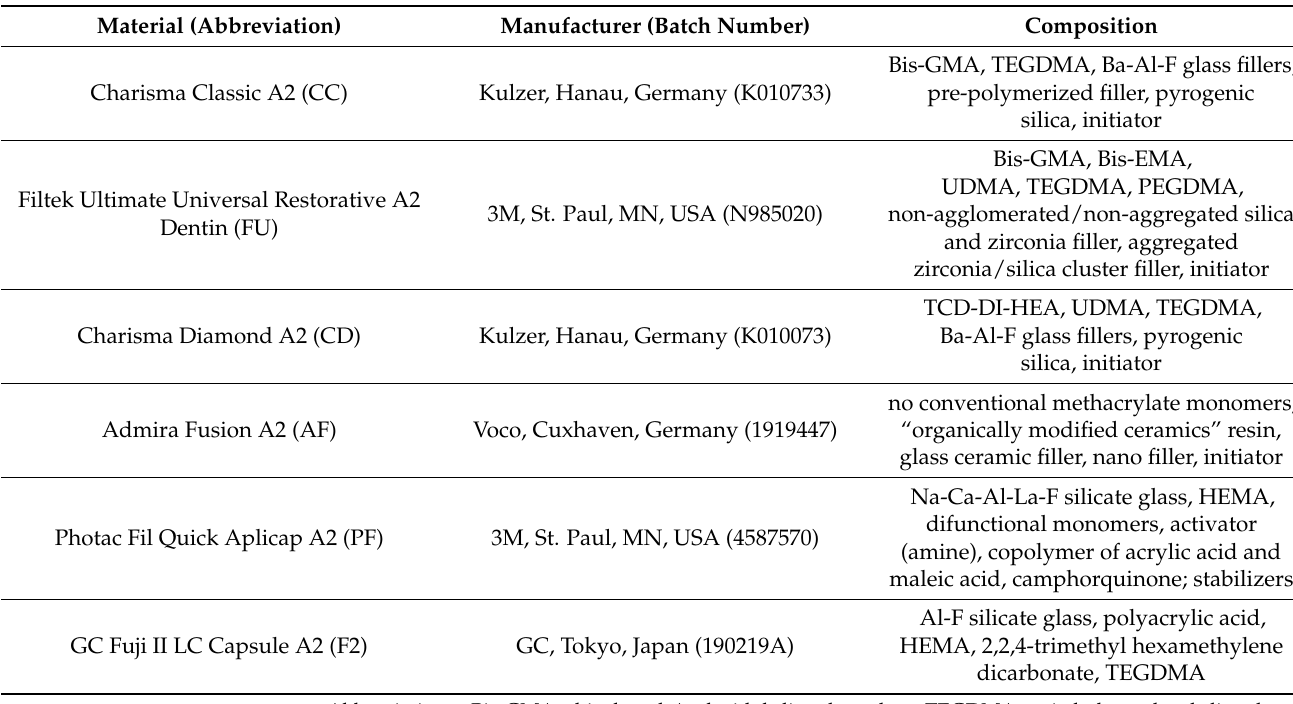
Table 1. Composition of materials tested in this